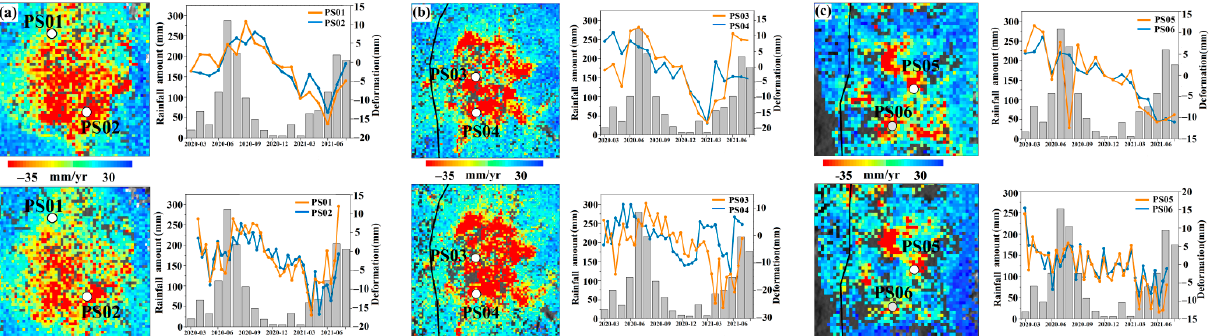
Figure 11. Relationship between deformation and rainfall response in zones A, B. ( a ) Relationship between deformation and rainfall response in Zone A (first row represents the deformation velocity of Radarsat-2; the second row represents the deformation velocity of Sentinel-1A). ( b ) Relationship between deformation and rainfall response in zone B (first row represents the deformation velocity of Radarsat-2; the second row represents the deformation velocity of Sentinel-1A). ( c ) Relationship between deformation and rainfall response in zone C (first row represents the deformation velocity of Radarsat-2; second row represents the deformation velocity of Sentinel-1A).